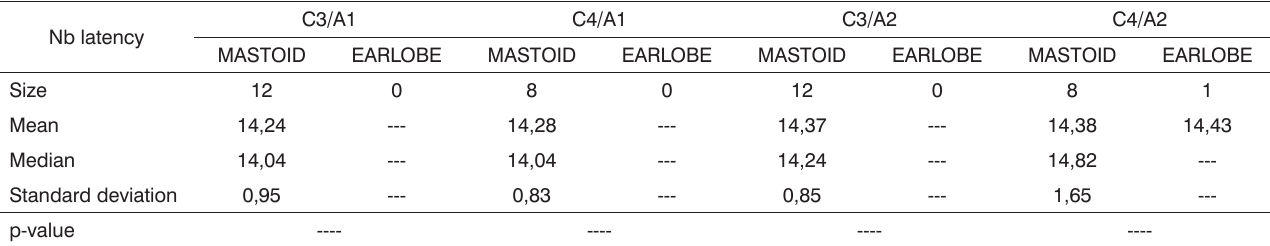
Table 7. PAR average values for both ears in the C3/A1, C4/A1, C3/A2 and C4/A2 modes, with the electrode placed on the mastoid and earlo- be. C3/A1 C4/A1 Nb latency